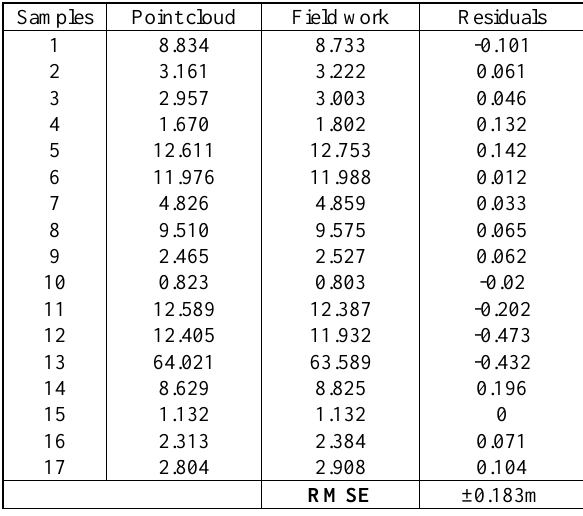
Table 6 The residuals between distance from point cloud and field work The residuals are then used to calculate the RMSE value. The RMSE from the residuals is 0.183m. Root Mean Square Error (RMSE) is the standard deviation of the residuals (prediction errors). Residuals are a measure of how far from the regression line data points are; RMSE is a measure of how spread out these residuals are.